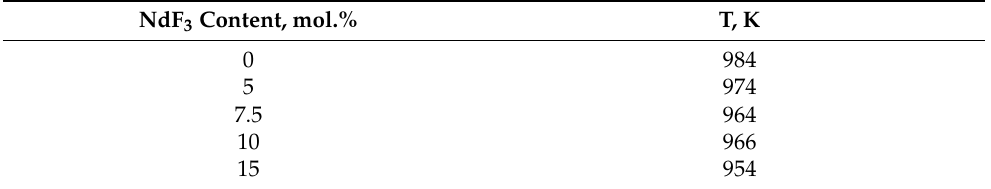
Table 1. Liquidus temperature of (NaF-KF) eut -NdF 3